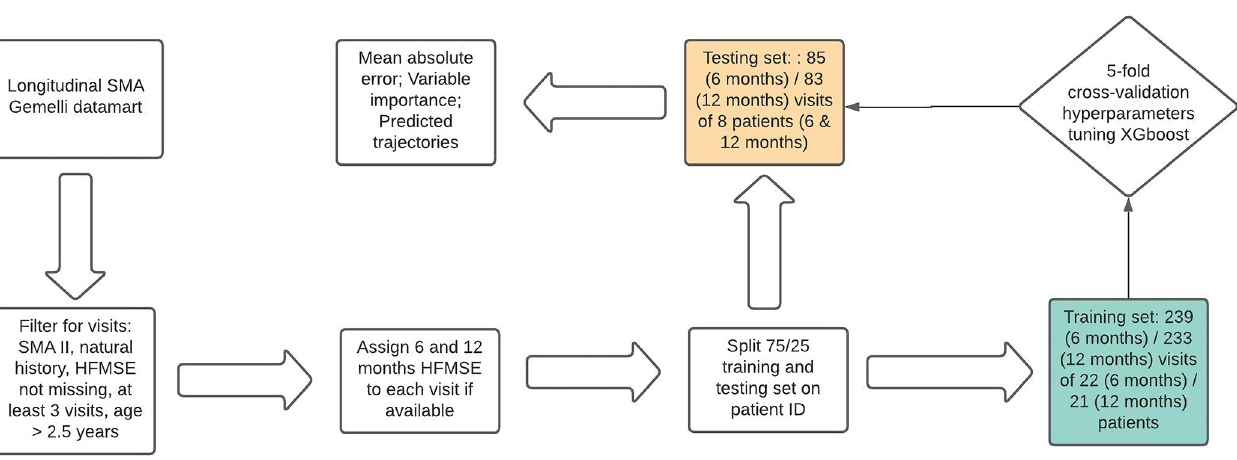
Fig 1. Workflow of the machine learning analysis for the